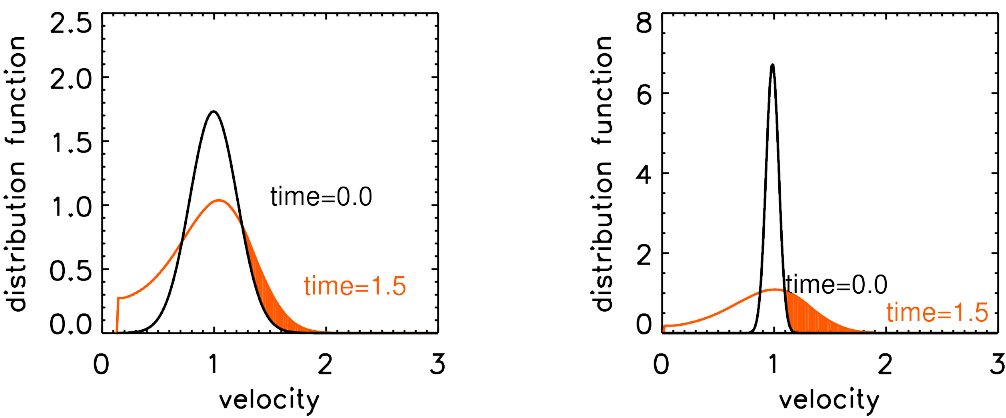
Fig. 4. f for different moments of time (in arbitrary units). The initial electron beam distribution, f , is plotted in black and the final distribution, f , is plotted in brown. The right and left panels correspond to the different width of the beam with respect to its energy 1v ( 1v = 0 . 2 and 1v = 0 . 08) within the velocity